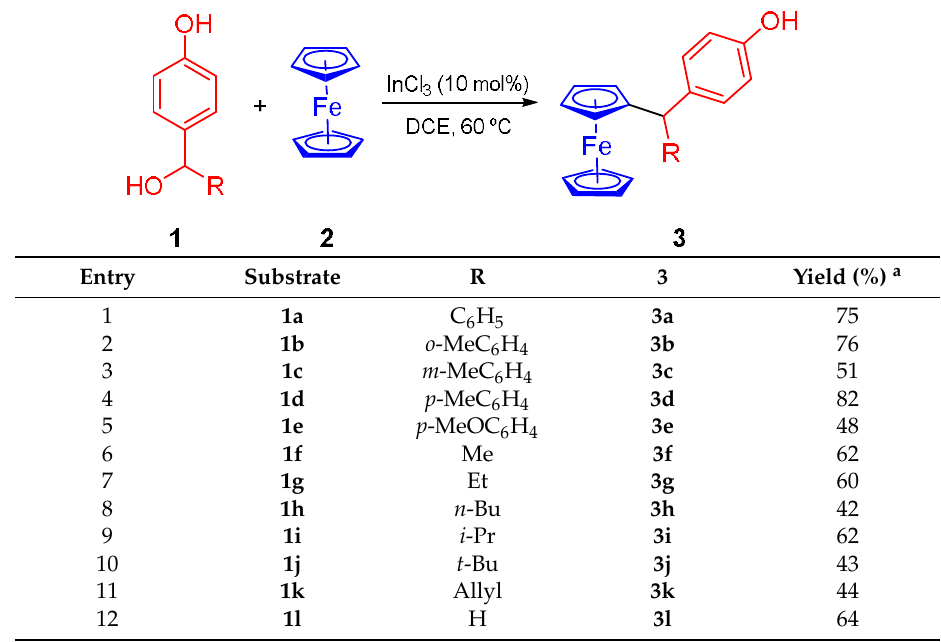
Table 1. InCl 3 -catalyzed reaction of p -hydroxybenzyl alcohols 1 and ferrocene ( 2 ).